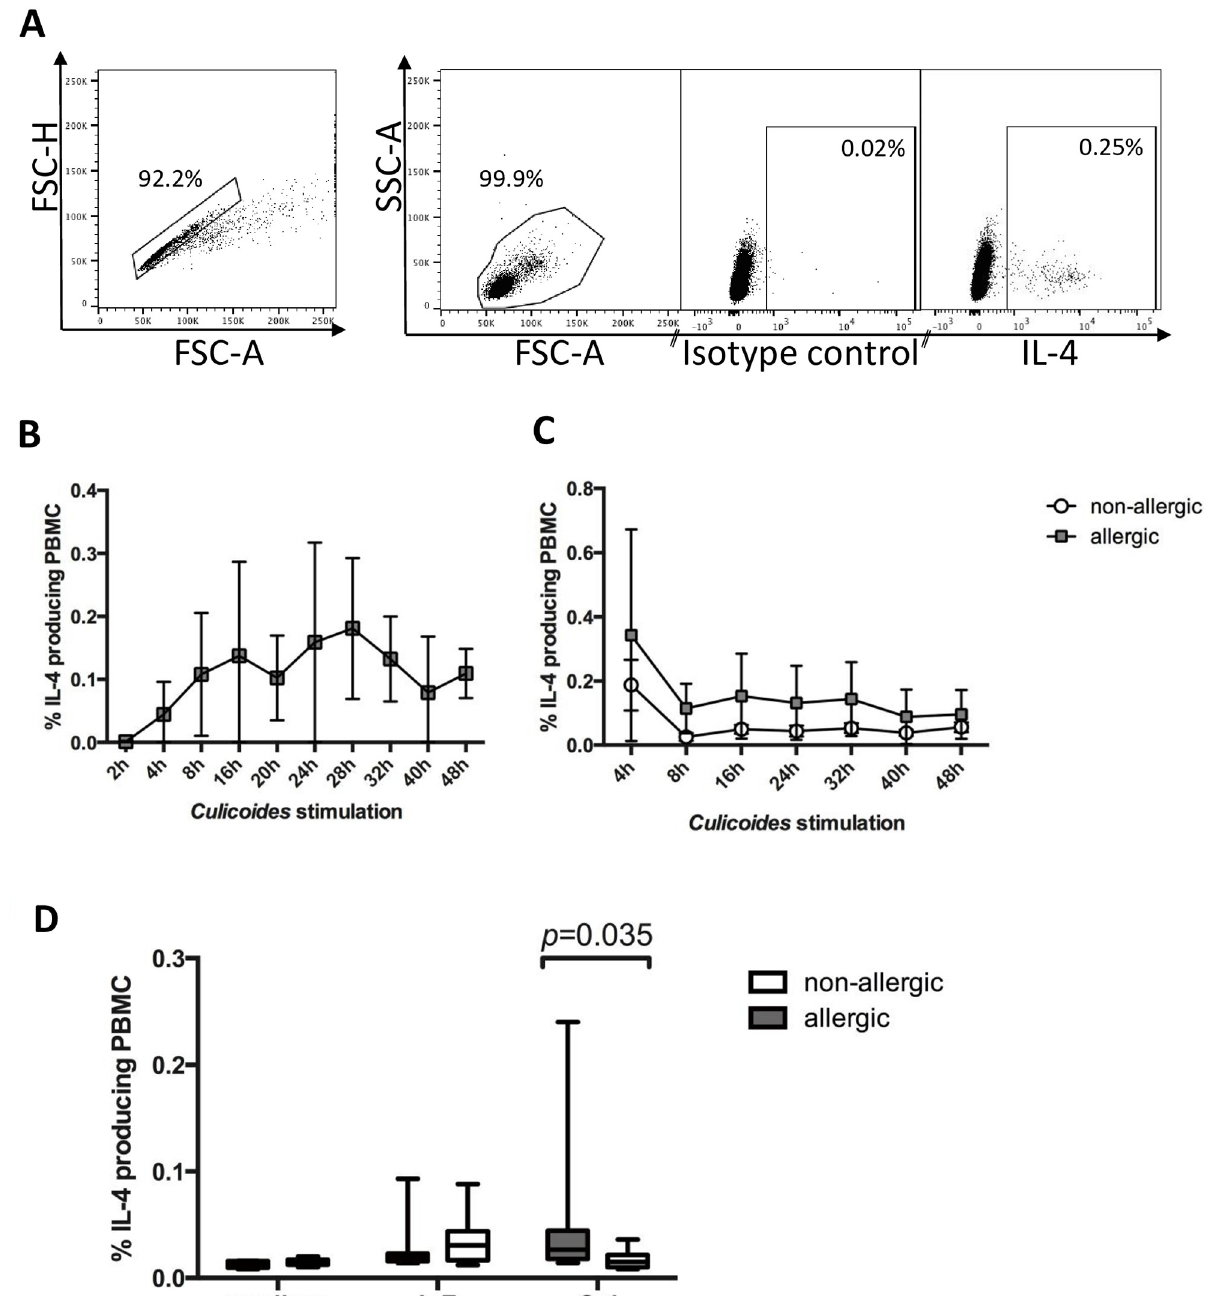
Fig 2. Flow cytometric analysis of IL-4 + cells after stimulation of PBMC from allergic and non-allergic horses with anti-IgE or Cul extract. PBMC were stimulated in vitro with crosslinking anti-IgE mAb 134 or Cul in the presence of the secretion blocker Brefeldin A. After incubation, the cells were fixed, stained for intracellular IL-4 production, and analyzed by flow cytometry. A) Gates were set for doublet exclusion (FSC-H/FSC-A) and on PMBC by forward and side scatter characteristics (FSC-A/SSC-A). PBMC were then analyzed for IL-4 expression in comparison to the isotype control. B) PBMC from two allergic horses were stimulated with Cul in the presence of the secretion blocker Brefeldin A for different times between 2–48 hours. Cells were fixed after incubation and stained for intracellular IL-4. C) PBMC from allergic (n = 5) and non-allergic horses (n = 5) were stimulated for 4–48 hours with Cul and Brefeldin A was only added for the last four hours of incubation. D) Percentages of IL-4 + PBMC from horses with CH (n = 8) and non-allergic controls (n = 8) were isolated in August, stimulated for four hours with anti-IgE 134 or Cul or kept in medium as control.